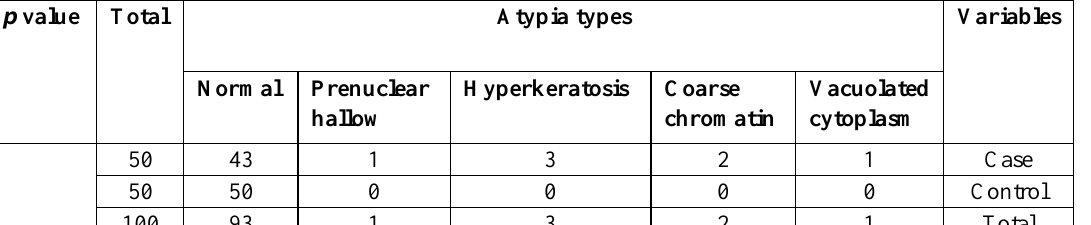
Table 7. Correlation between atypia type and cytological